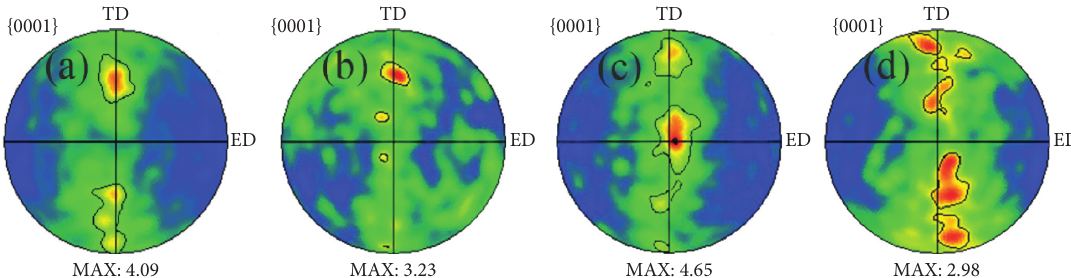
Figure 9: Pole figures of (a) MYZ, (b) MYZC, (c) MYZN, and (d) MYZCN extruded